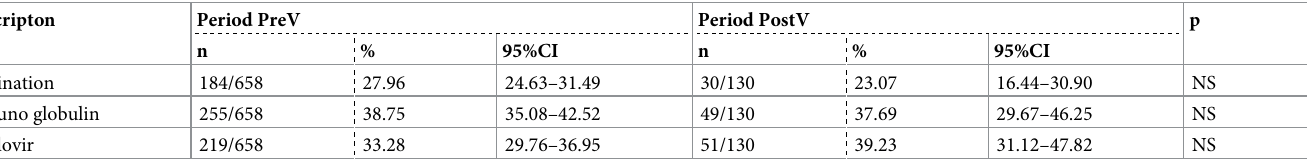
Table 3. Management of susceptible contacts pre- and